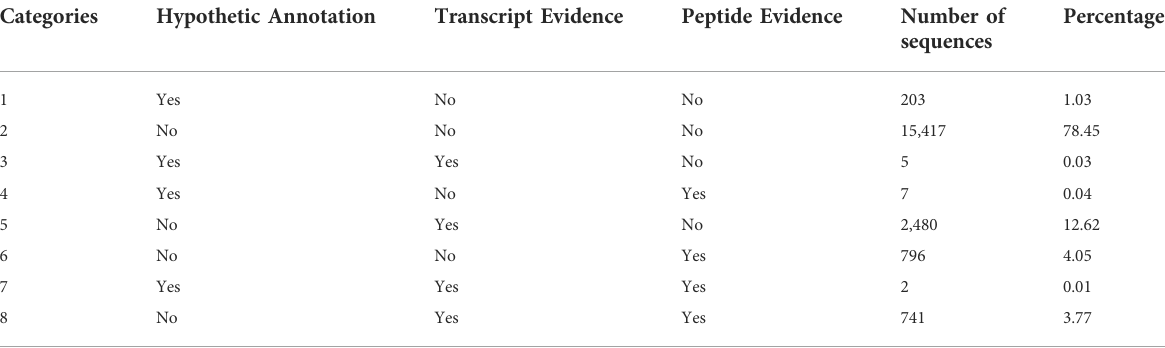
TABLE 2 Classi fi cation table of annotated proteins by AnnotaPipeline for the Arabidopsis thaliana